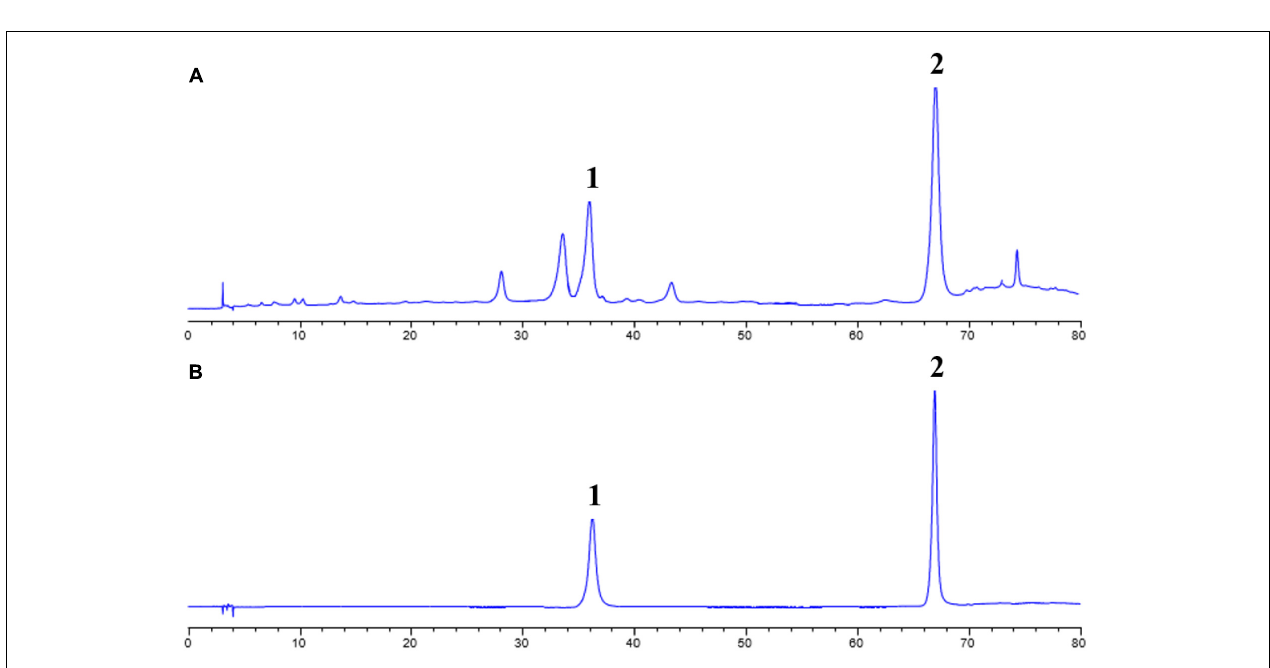
FIGURE 1 | High performance liquid chromatography (HPLC) analysis for CCE (A) and mixed reference substance (B) . This analysis was performed at 350 nm detection wavelength with mobile phase of acetonitrile and 0.5% acetic acid-water solution.